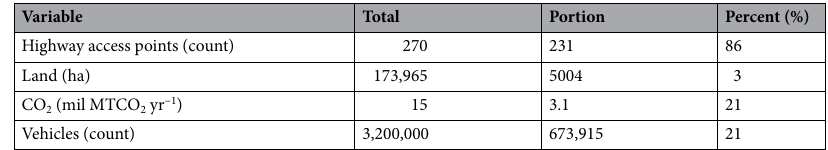
Table 1. Summary of model results reflecting total number of highway access points in the network, portion and percent of those highway access points serviceable by AVS; total land supply available, portion and percent of land supply needed to power serviceable highway access points in the network; total annual CO 2 emissions in Oregon from passenger vehicle use and the portion and percent of those annual emissions this approach has the potential to reduce; and total passenger vehicles registered in Oregon and the equivalent number of vehicles and percent this approach has the potential to support as electric